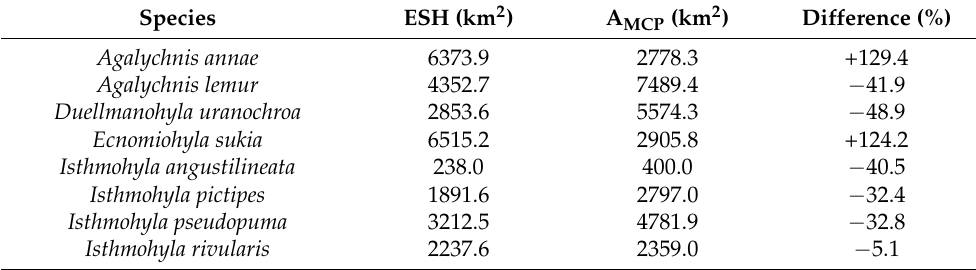
Table 2. Estimations of the extent of suitable habitat (ESH) and the area of minimum convex polygon (A MCP ). The table also shows the percent of the difference in area by comparing the ESH against the A MCP